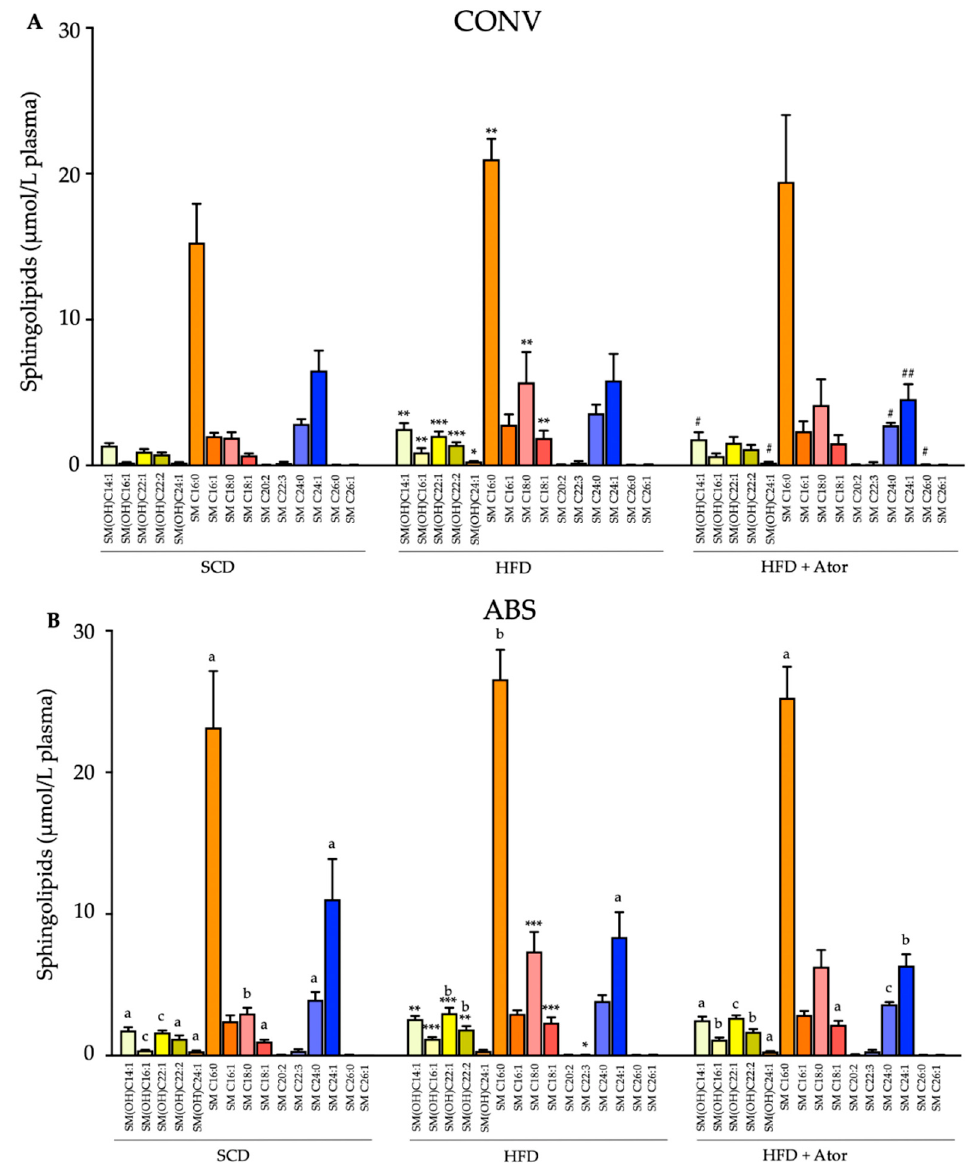
Figure 4. Blood sphingolipids in CONV ( A ) ( n = 14) and ABS ( B ) ( n = 13) mice under SCD or HFD and their changes upon Ator treatment. Error bars indicate SEM. Comparison between SCD vs. HFD is labelled with * and between HFD vs. HFD + Ator with #. The letters a,b and c indicate the comparison between CONV mice and the respective diet / treatment regimes in ABS mice. *, #, a indicate p < 0.05; **, ##, b indicate p < 0.01; ***, ###, c indicate p < 0.001.